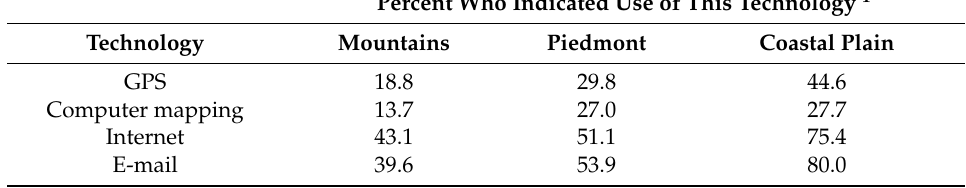
Table 6. Percentage by physiographic region of logging business owners indicating use of different technologies in their business.